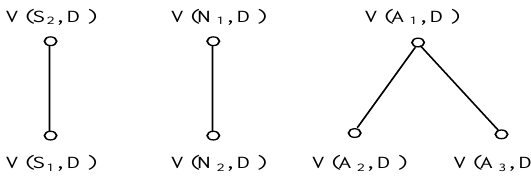
Fig. 5. Partial order amongst